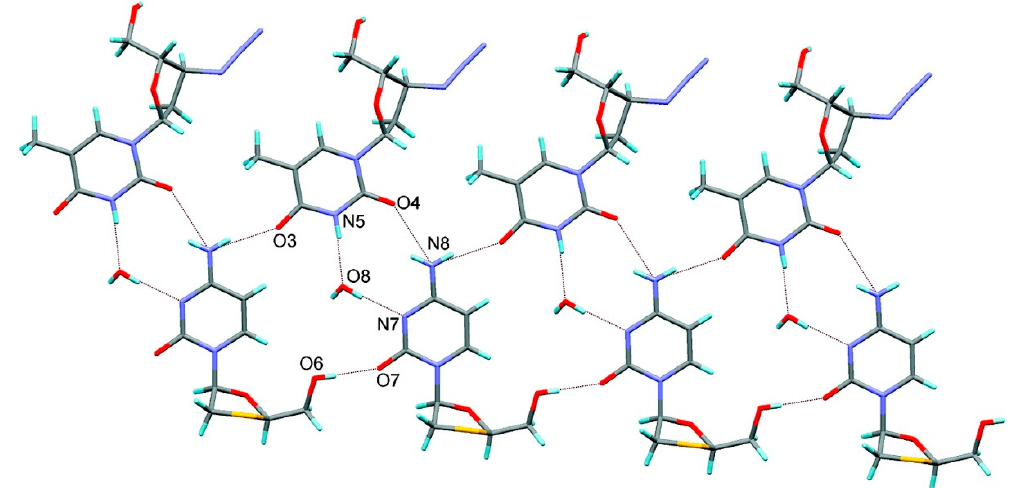
Figure 32. 1D ribbon-type arrangement in lamivudine–zidovudine hydrate cocrystal. Adapted with